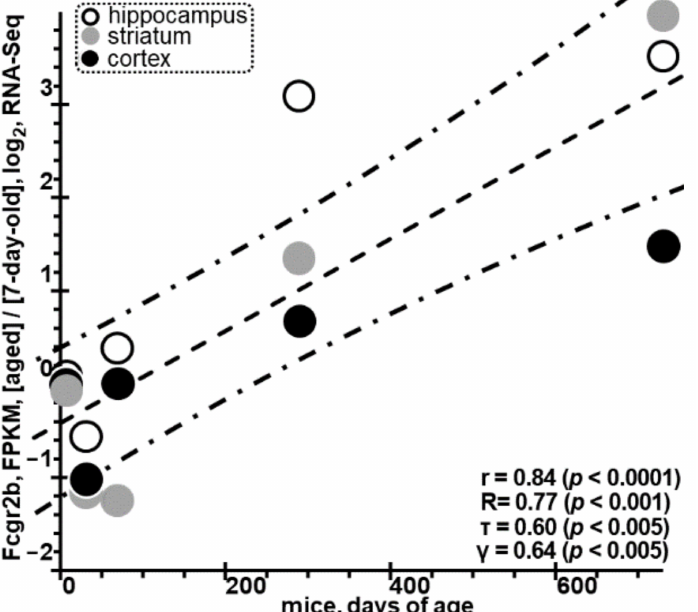
Figure 4. An RNA-Seq experiment run within the mouse model of human ARDs [217] revealed a statistically significant increase in Fcgr2b expression in astrocytes from the hippocampus (open circles, ), striatum (gray circles, • ) and cortex (black circles, • ) with increasing age, providing (cid:35) independent in vivo evidence in support of this finding. Legend: See the legend to Figures 1 and 2; FPKM, fragments per kilobase of transcript per million mapped reads